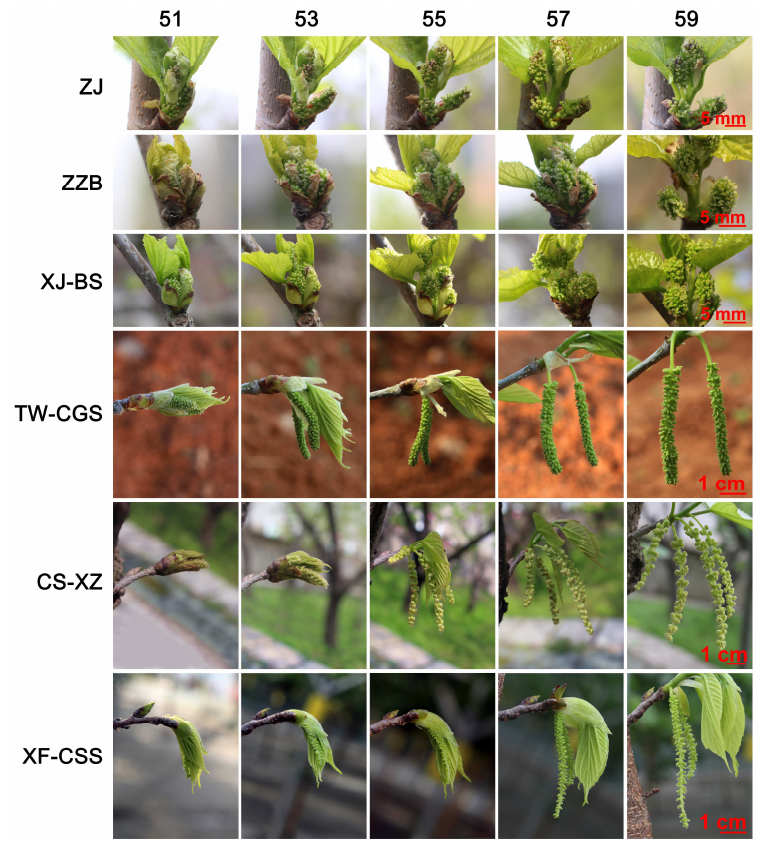
Figure 4. Stages of inflorescence emergence for mulberry according to the BBCH scale. Buds are densely covered with hairs in CS-XZ.